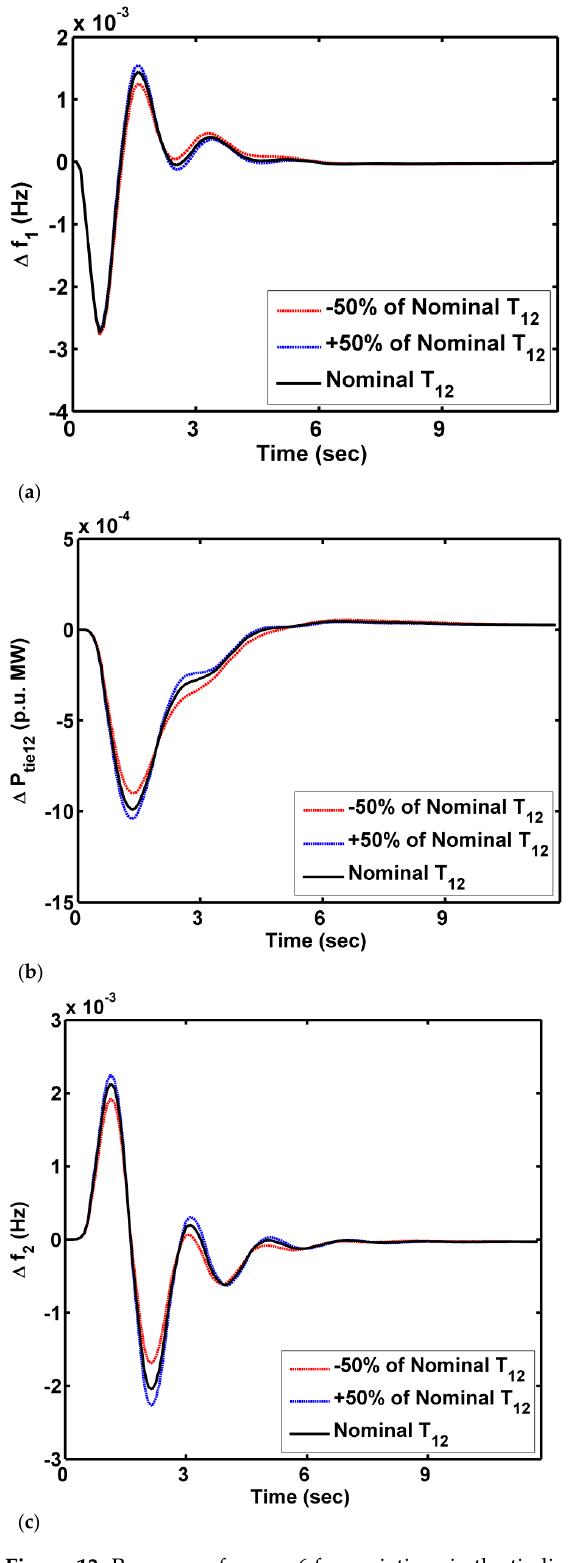
Figure 13. Responses for case 6 for variations in the tie-line coefficient: ( a ) ∆ f 1 ( b ) ∆ P tie 12 and ( c ) ∆ f 2